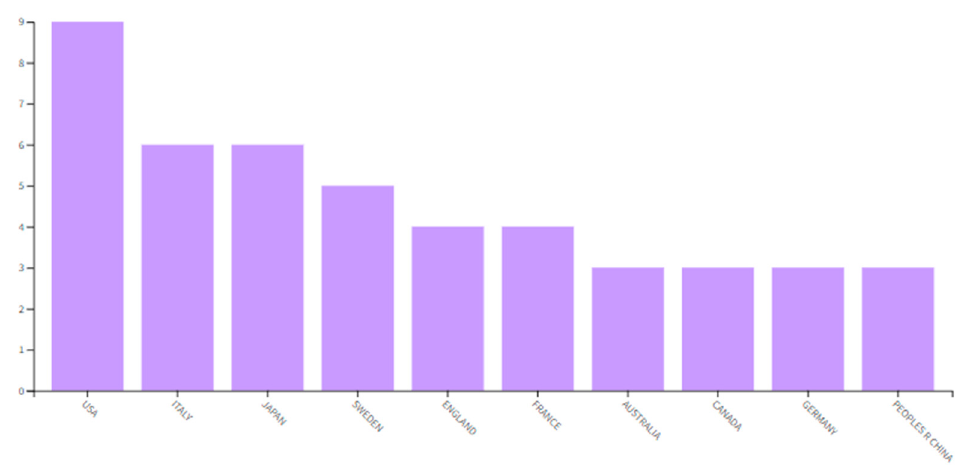
Figure 9. Countries with the highest number of publications—Web of Science.